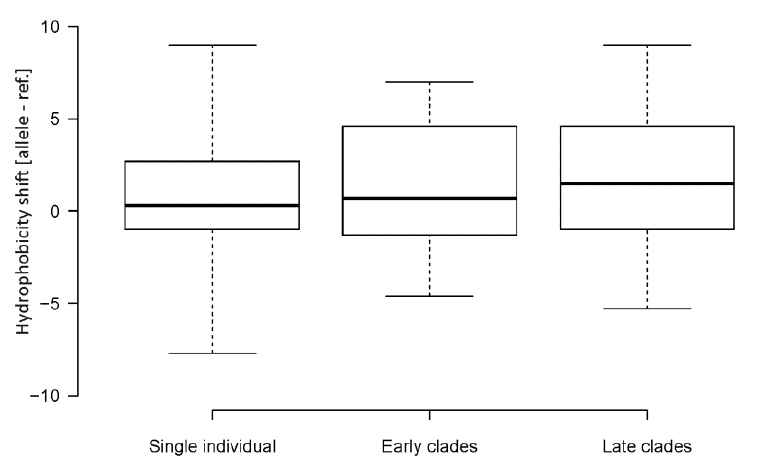
Figure 4. Shifts in amino acid hydrophobicity caused by SNVs in SARS-CoV-2 genomes. Box plots were constructed from were constructed from data sets in Table S6. Boxes—Q1 and Q3 quartiles. The vertical line inside the data sets in Table S6. Boxes – Q1 and Q3 quartiles. The vertical line inside the box marks the median. Whiskers extend to box marks the median. Whiskers extend to the minimum and maximum values. Hydrophobicity the minimum and maximum values. Hydrophobicity scales are according to Kyte and Doolittle [33]. Lineage groups are scales are according to Kyte and Doolittle [33]. Lineage groups are as in Table 1. The number of as in Table 1. The number of SNVs are indicated in each group. Differences between the groups were not significant (p > 0.05, Mann–Whitney U test).